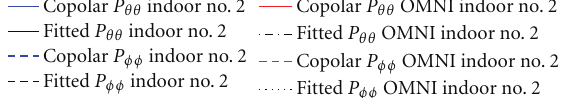
Figure 9: CDFs for di ff erent combination methods in indoor number 2 scenario at 61.5 GHz and directional